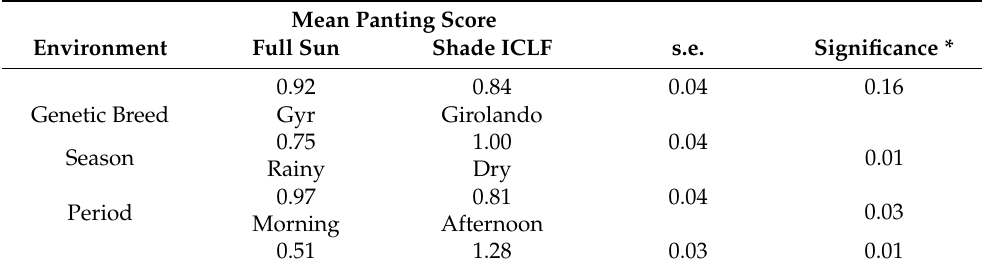
Table 7. Panting scores of Gyr and Girolando dairy cows in full sun and shade ICLF obtained in the dry and rainy seasons in the morning and afternoon